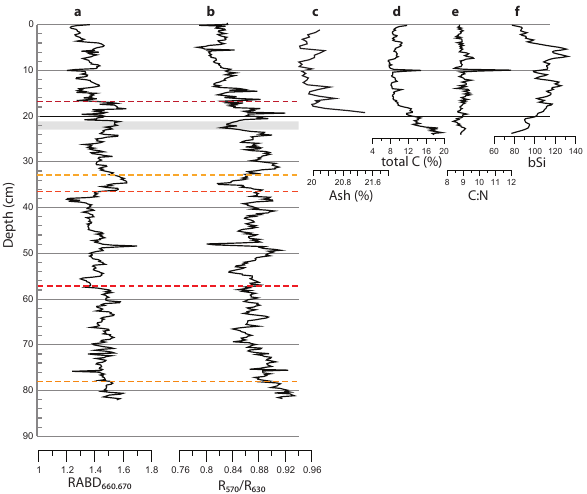
Fig. 3. This figure shows the multi-proxy dataset for core CHEP 06/03 and the ash content measured on parallel core CHEP06/04. The proxies derived from spectral scanning of the cores in the vis- ible light range are (a) RABD 660 / 670 , which is known to repre- sent chlorins (chlorophyll decay products) in the sediments, and (b) R 570 / R 630 , a proxy for the mineral (clay) content of the core. The latter is, as expected, significantly correlated to the ash content (LOI-1) shown in (c) . The total amount of carbon (d) , C:N ratios (e) and total biogenic Silica (f) are also shown for the upper part of the sediment core. The grey horizontal bar indicates the level of the light-colored sediment layer which was interpreted as the dam building phase. Colored horizontal lines in (a) and (b) reflect the five most significant splits (clusters) of the VIS-RS dataset.